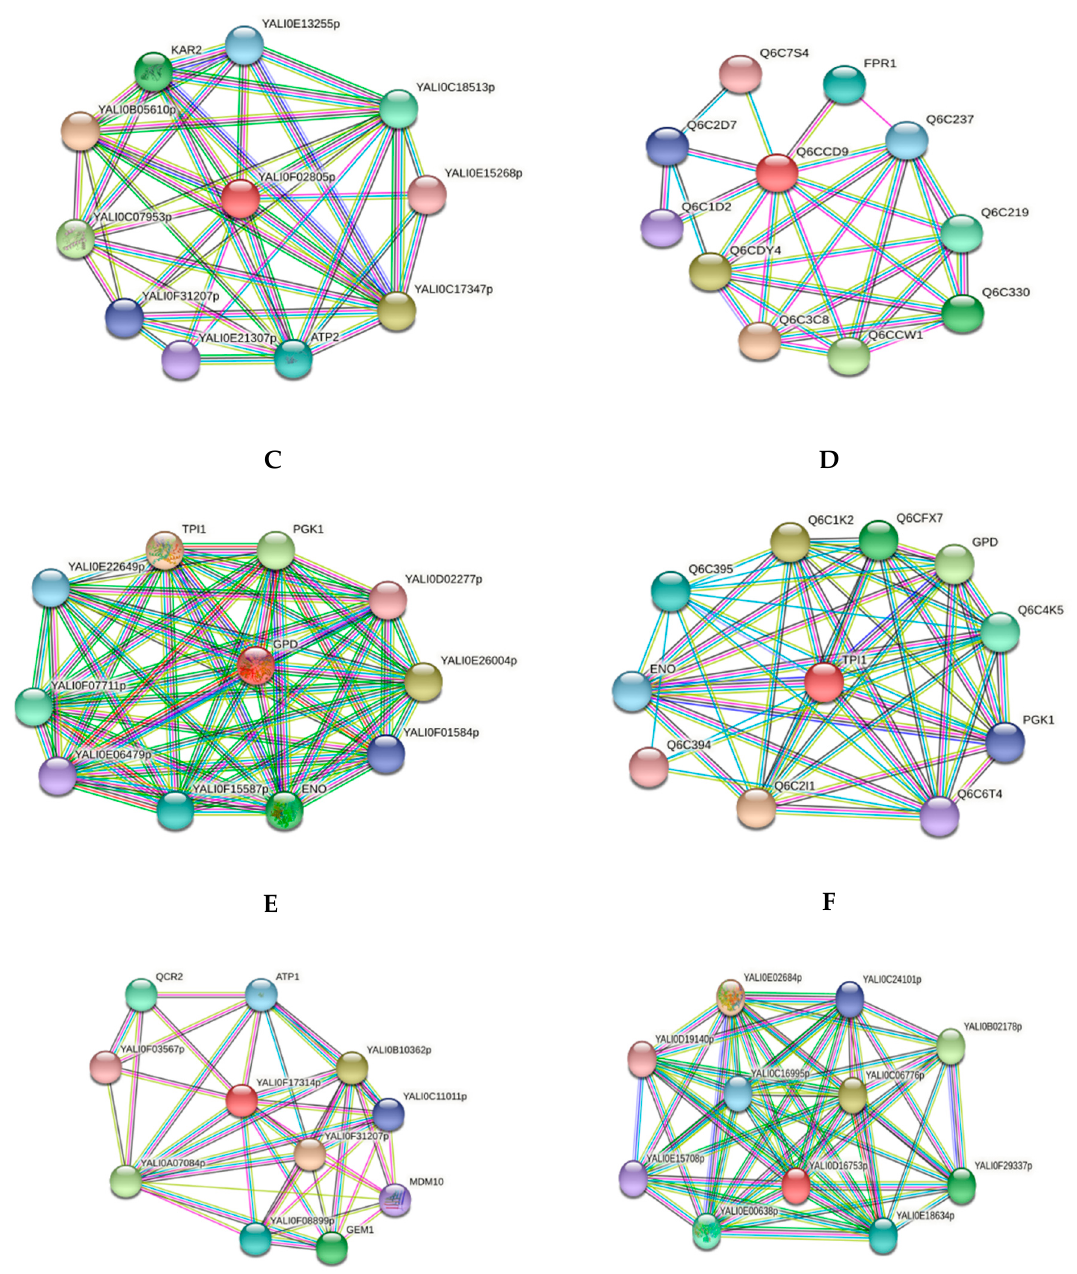
Figure 4. Network analyses of functional associations and/or interactions of up-regulated proteins upon the adaptation to alkaline stress. Different clusters of interacting proteins were identified using the STRING software with the highest conformity score. The information on the proteins is summarized in the Supplementary Section (Table S2). ( A ) HSP60 heat shock protein—chaperone (YALI0F02805p) ( B ) Peptidyl-prolyl cis-trans isomerase (YALI0C10230p) ( C ) Glyceraldehyde-3-phosphate dehydrogenase (YALI0C06369p) ( D ) Triose phosphate isomerase (YALI0F05214p) ( E ) VDAC (YALI0F17314p) ( F ) Malate dehydrogenase (YALI0D16753p).